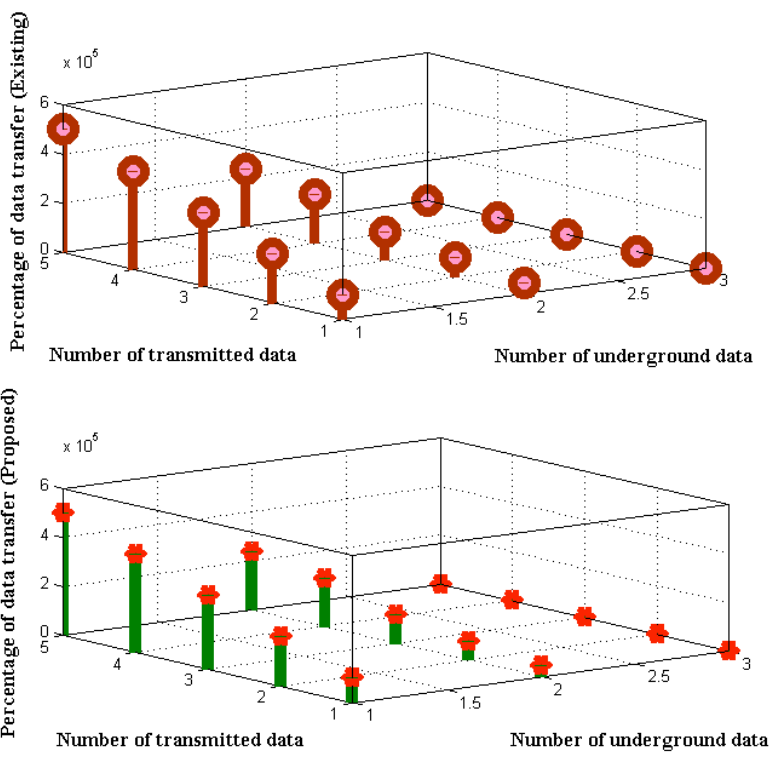
Figure 5. Percentage of data transfer.